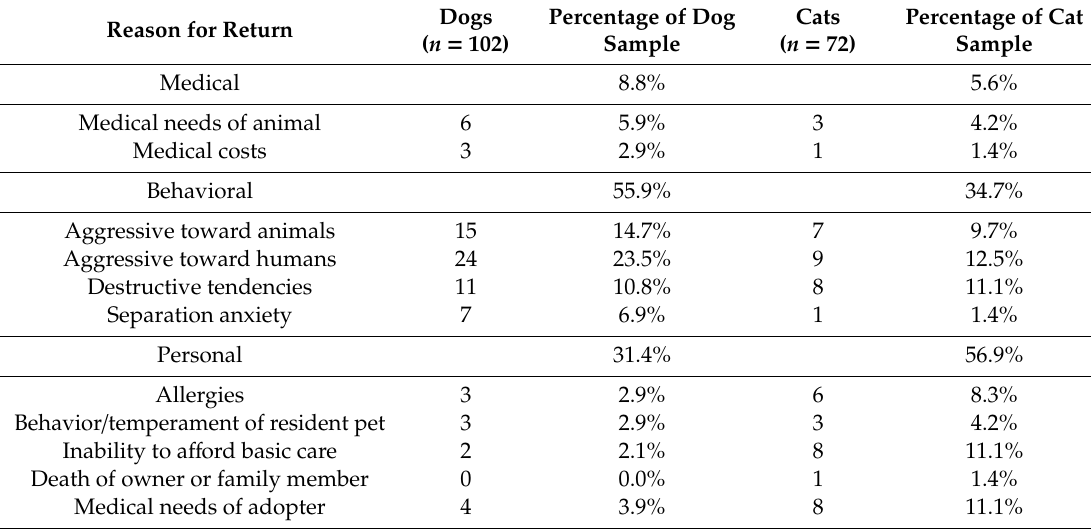
Table 5. Reasons for return by number of animals and percentage of the sample for cats and dogs who were returned to the shelter during the study period (3 July 2018 to 22 October 2018 for dogs and